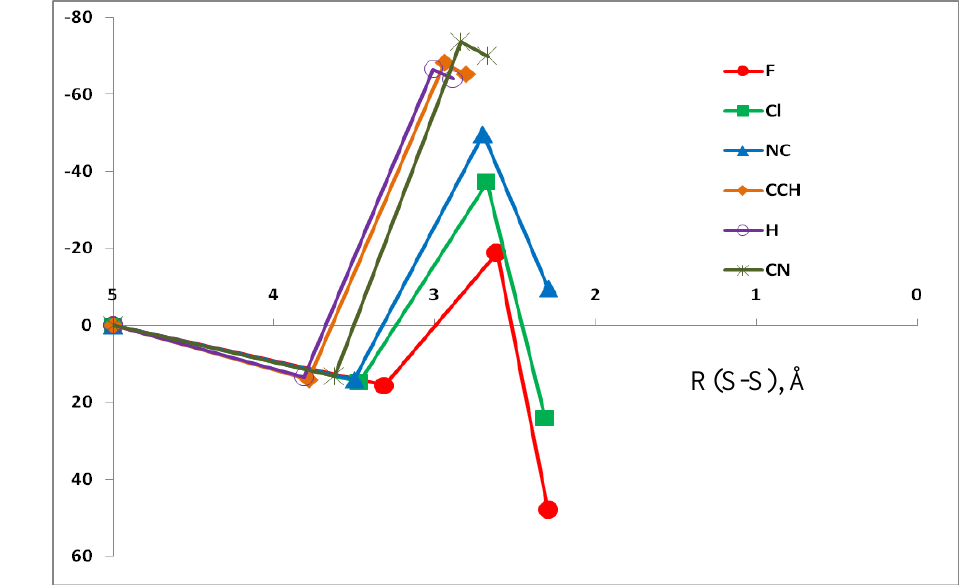
Figure 4. Binding energies of complexes, transition structures, and molecules as a function of the S–S distance. The points at 5 Å represent the noninteracting monomers HN(CH)SX and S=C=O.